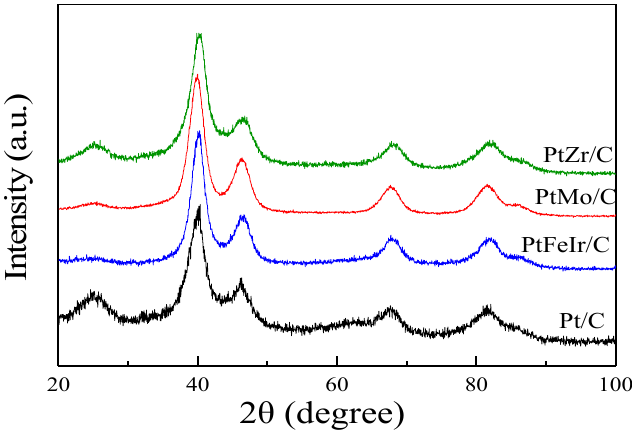
Figure 2. XRD patterns for the Pt-Mo/C, Pt-Zr/C, Pt-Fe-Ir/C, and Pt/C electrocatalysts.